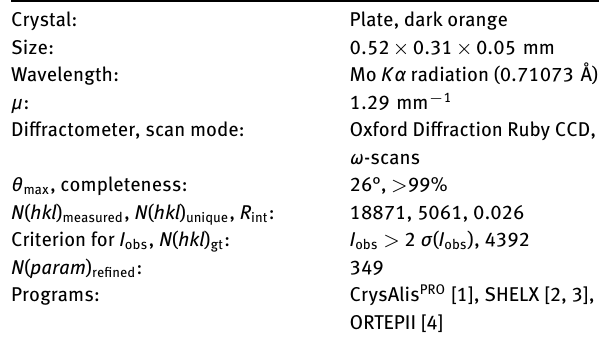
Table 1: Data collection and